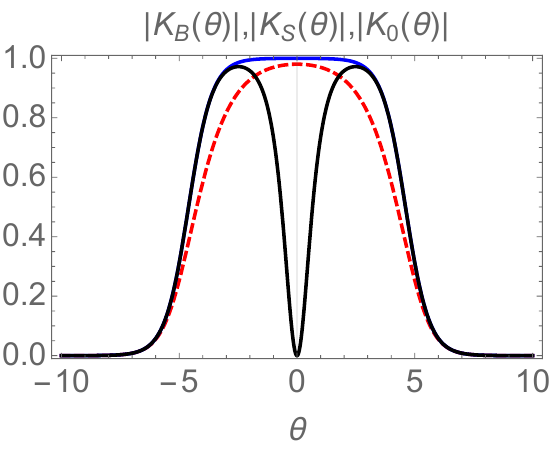
Figure 1 . The functions | K 0 p θ q| (black), | K S p θ q| (blue) and | K B p θ q| (red, dashed) for α “ 0 . 01 . In this case | log α | « 4 . 6 which is half the size of the plateau of the second function and also gives the location of the maxima of | K at θ “ ˘ log α . Reducing the value of α all functions become 0 p θ q| increasingly square-shaped, with K preserving its zero at the 0 p θ q